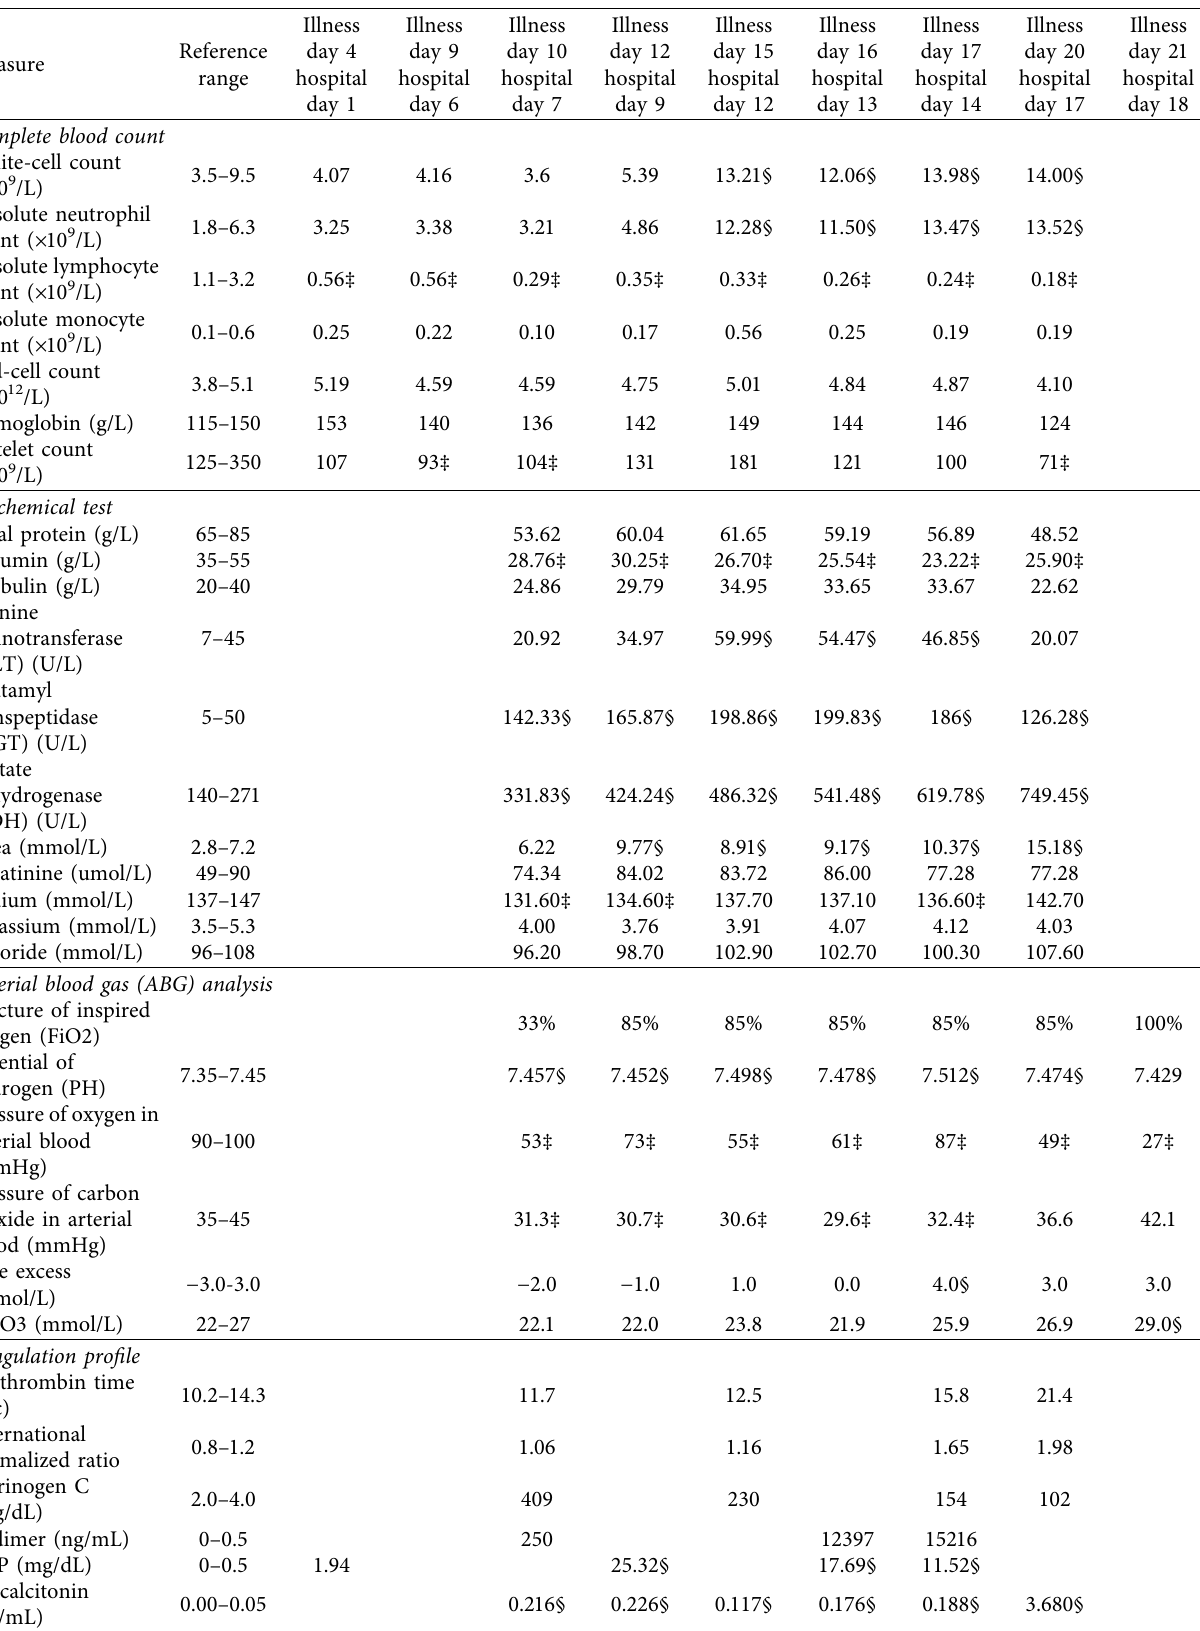
Table 6: Clinical laboratory tests of the